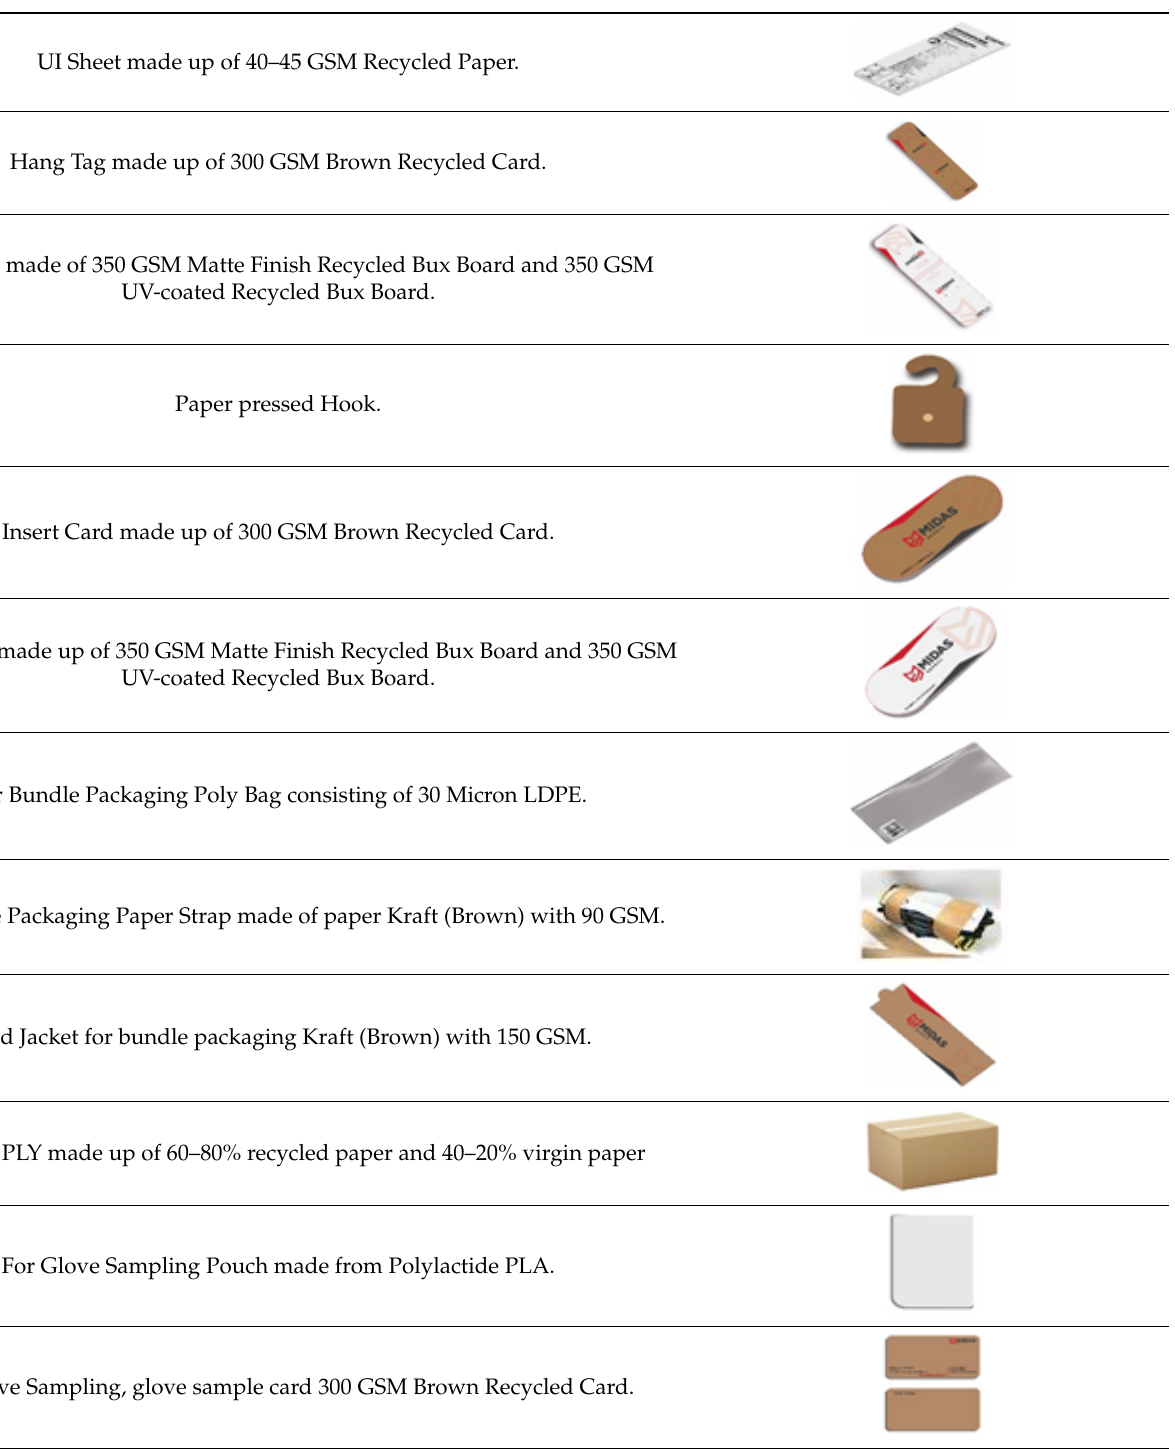
Table 1. Current packaging material at Midas Safety.